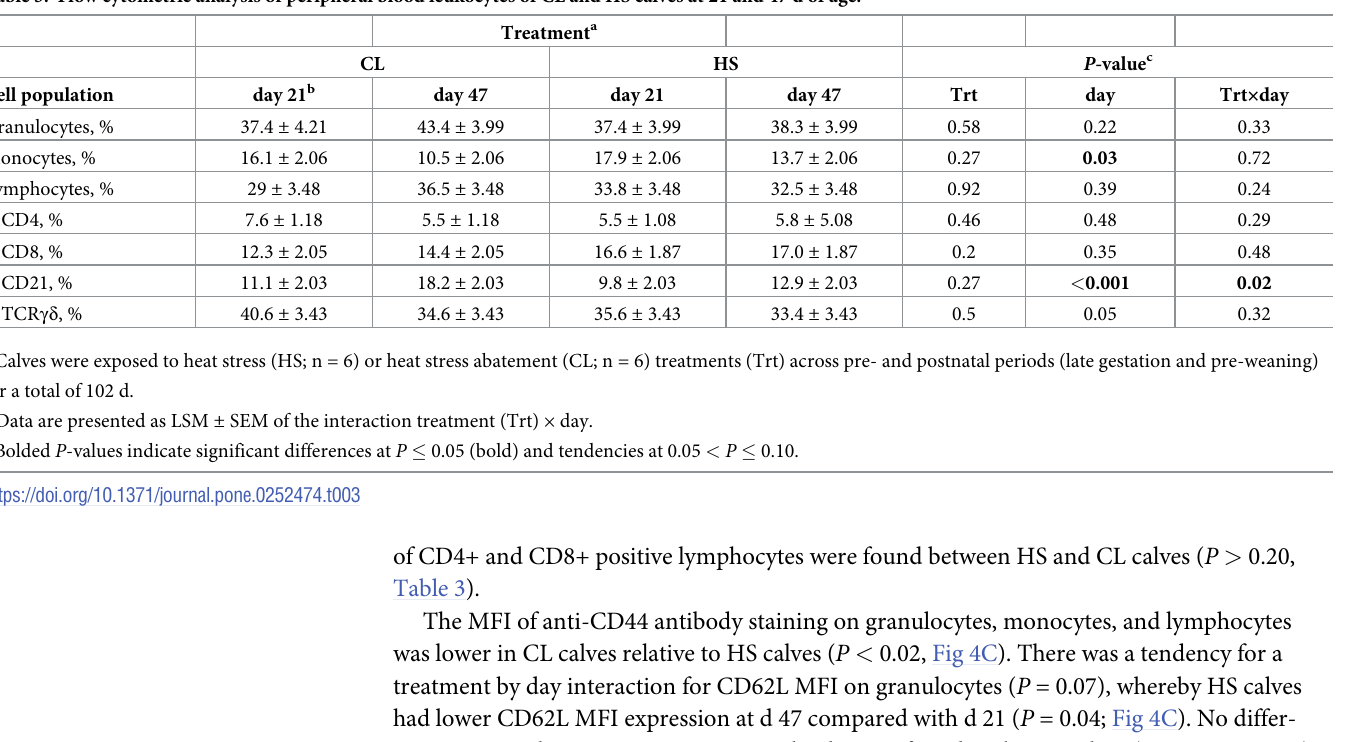
of CD4+ and CD8+ positive lymphocytes were found between HS and CL calves ( P > 0.20, Table 3). The MFI of anti-CD44 antibody staining on granulocytes, monocytes, and lymphocytes was lower in CL calves relative to HS calves ( P < 0.02, Fig 4C). There was a tendency for a treatment by day interaction for CD62L MFI on granulocytes ( P = 0.07), whereby HS calves had lower CD62L MFI expression at d 47 compared with d 21 ( P = 0.04; Fig 4C). No differ- ences in granulocyte CD62L expression by day was found in the CL calves ( P > 0.11; Fig 4C). Lymphocyte CD62L MFI had a day effect whereby lymphocytes from both treatments had lower CD62L expression at postnatal d 47 compared with d 21 ( P < 0.001; Fig 4C). No differ- ences were observed between treatments for monocyte CD62L MFI ( P > 0.16, Fig 4C).